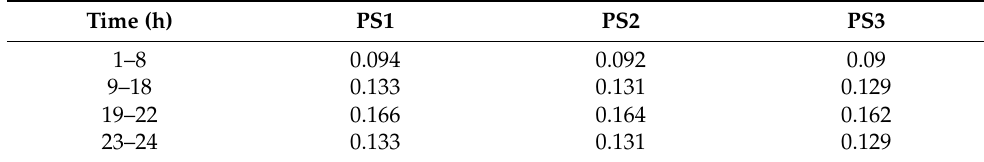
Table 1. Electricity for the case study (EUR/kWh).